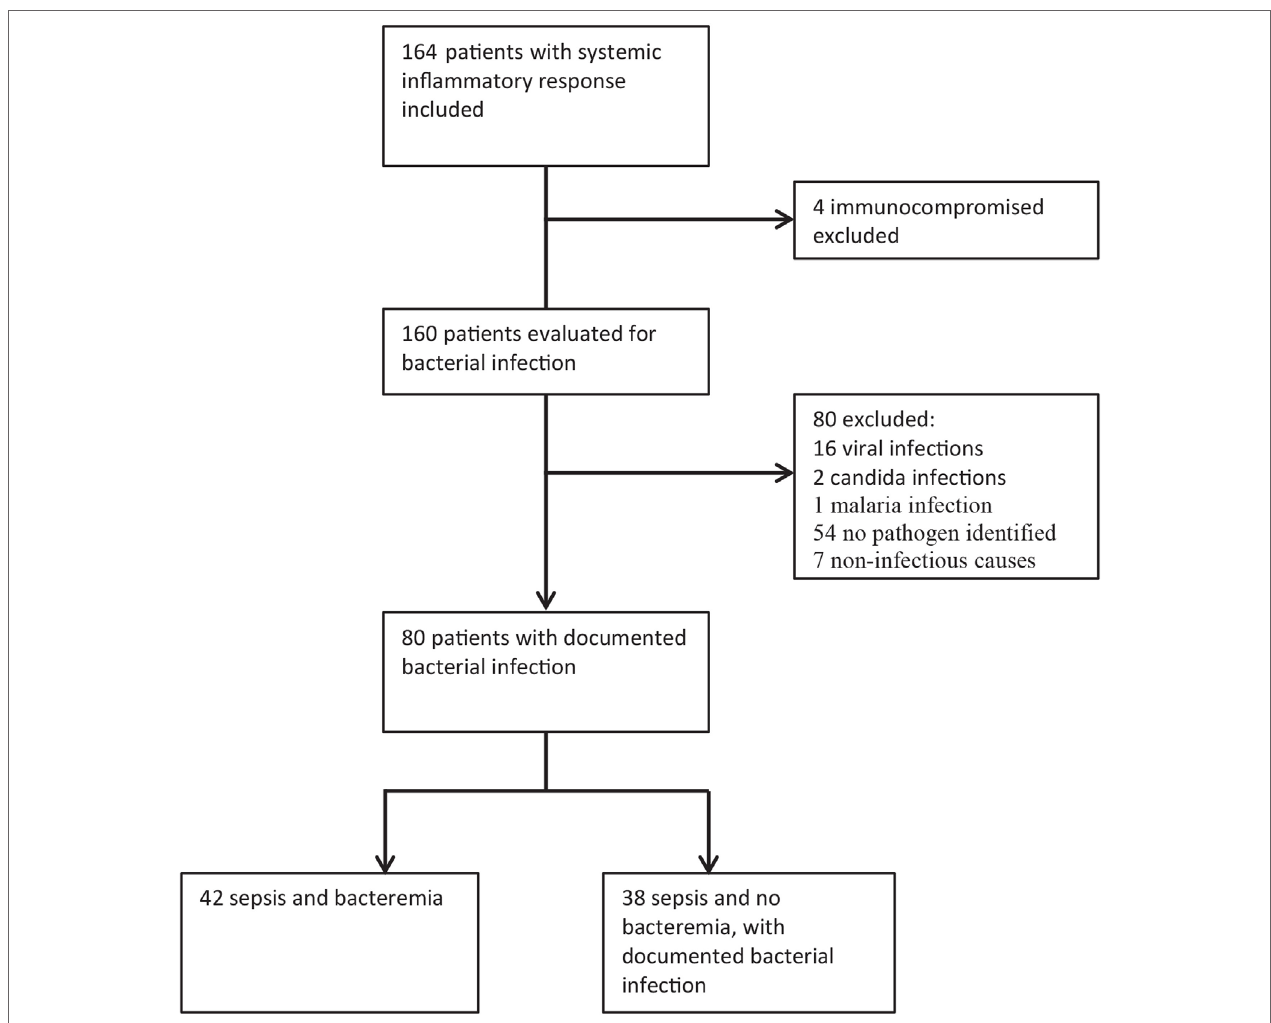
FigUre 1 | Patient enrollment and exclusion; the total number of included patients with systemic inflammatory response and the identification of immunocompetent patients with bacterial infections are shown in the figure. This study is based on the old sepsis definition, while the patients fulfilling the new sepsis definition is discriminated in Figure 4 [total sequential (sepsis-related) organ failure assessment ≥